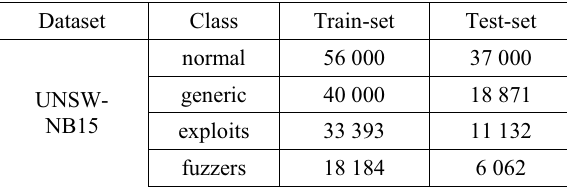
Table 1. UNSW-NB15